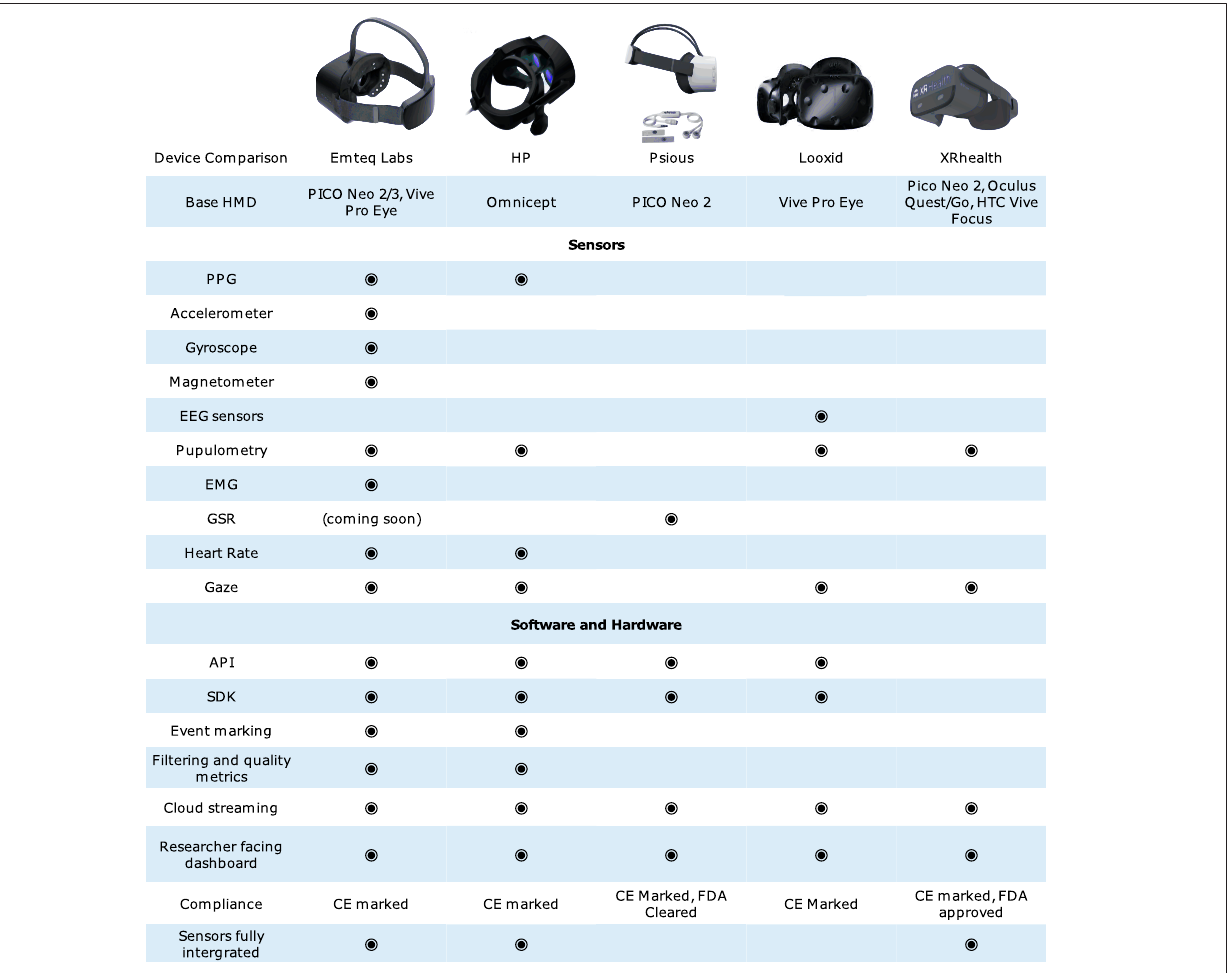
FIGURE2| Listofrelevantsensingsystemsusedforcollectionofbiofeedbackinvirtualreality.Sensor,software,andhardwaredifferencesarehighlightedbetween each platform for a straightforward comparison of each device.